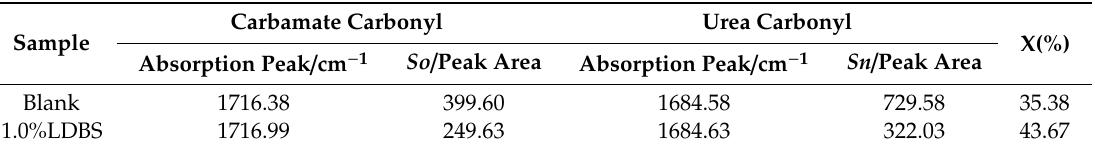
Table 6. Analysis results of the carbonyl infrared spectrum.